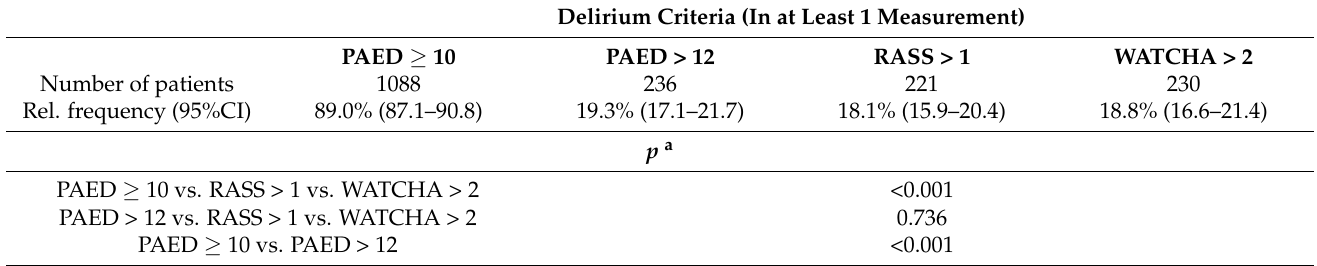
Table 2. Emergence Delirium (in at least 1